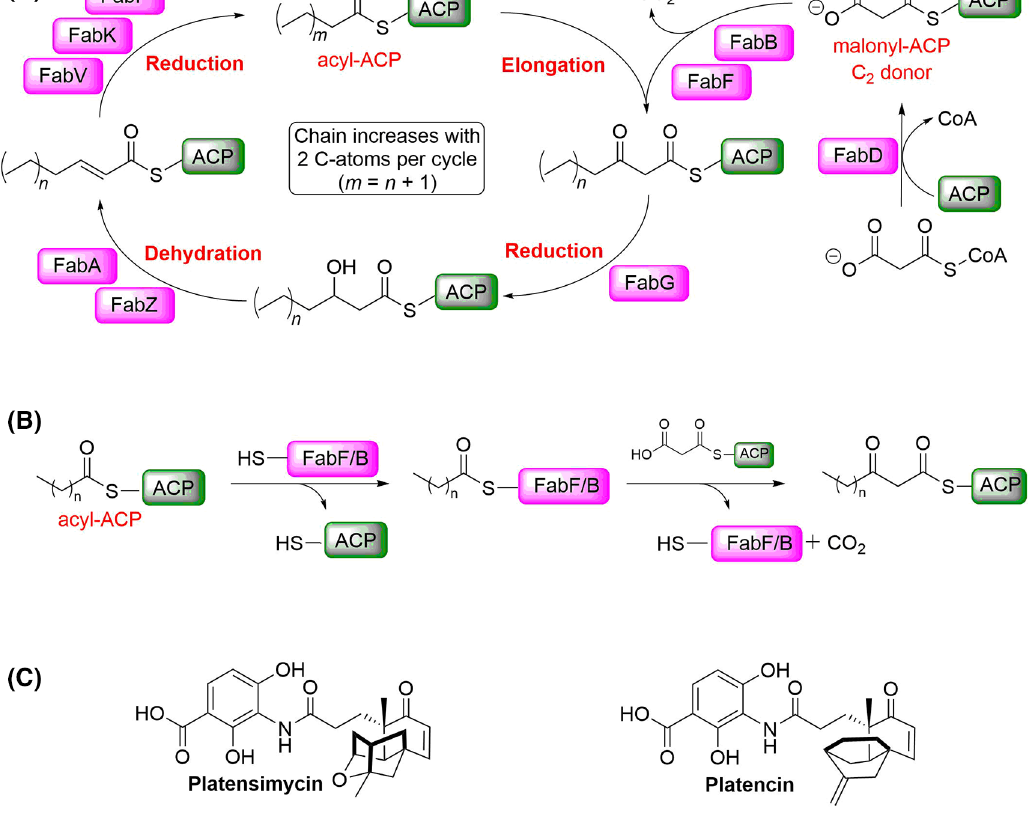
Figure 1. FAS II pathway and its inhibitors. A) Schematic overview of the elongation part of the FAS II pathway. B) Condensation reaction catalysed by FabF/B. (ACP: acyl carrier protein). C) Platensimycin and platencin have been reported as dual FabF/B